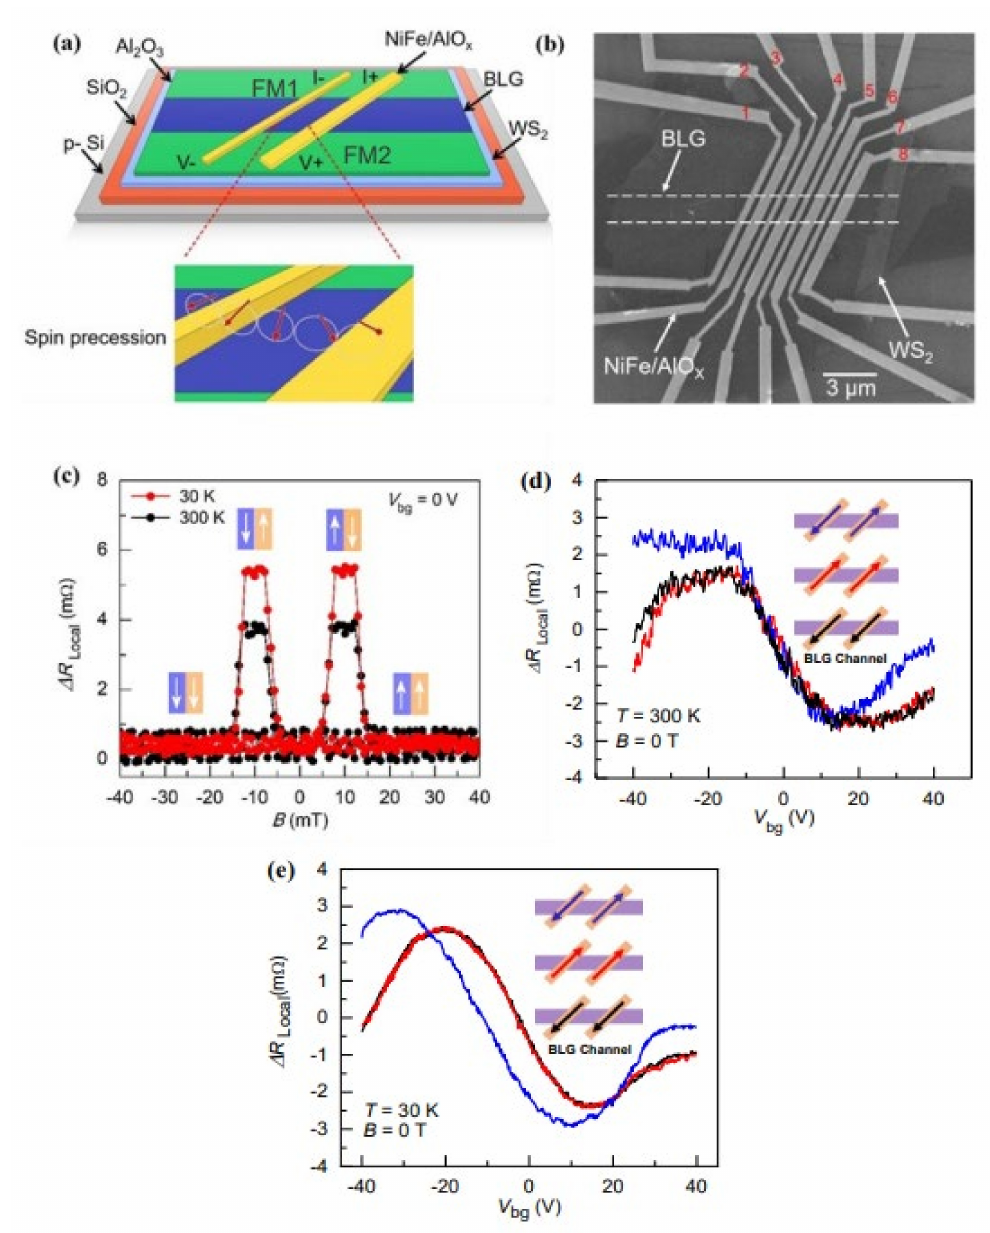
Figure 1. ( a ) Schematic representation of the BLG/ML-WS 2 spin FET. ( b ) Scanning electron microscope image of a complete BLG spin FET. ( c ) LSV signal as a function of parallel magnetic field at 300 K and 30 K at V bg = 0 V, where ∆ R Local = R − R p and R p = 1178.3 Ω . ( d ) LSV signal as a function of V bg at B = 0 T and at T = 300 K for anti-parallel (blue line), parallel (red line), and parallel (black line), respectively. ( e ) LSV signal as a function of V bg at B = 0 T and at 30 K for anti-parallel (blue line), parallel (red line), and parallel (black line), respectively. The LSV signals are moving-averaged to remove noise from a data